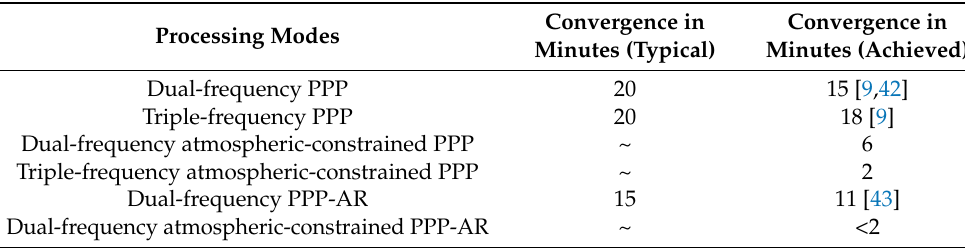
Figure 11. 95th percentile time series showing horizontal positional error (hourly) based on 24 hourly solutions for 40 stations for dual-frequency GREC with GPS-AR processing mode. Blue dotted line represents the 10 cm convergence threshold. Table 3. Improvements in convergence time achieved in comparison to typical convergence periods (to 10 cm horizontal) defined by the mode of PPP processing. Convergence in Convergence Processing Modes Minutes (Typical)